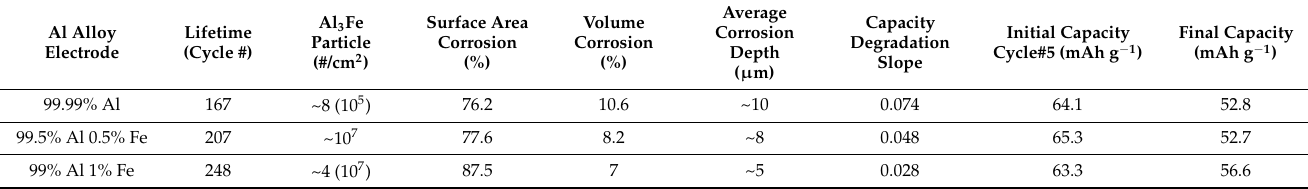
Figure 2. ( a ) Cycling performance of Al-NG battery using Al alloy anodes with various Fe content at a current density of 0.5 A g − 1 , ( b ) Galvanostatic charge/discharge curves of an Al-NG battery using 99% 1%Fe Al alloy anode at 5th, 50th, 100th, 150th, and 200th cycles for a current density of 0.5 A g − 1 . Table 1. Summary of data from cycling performance, SEM analysis, and corrosion calculations.